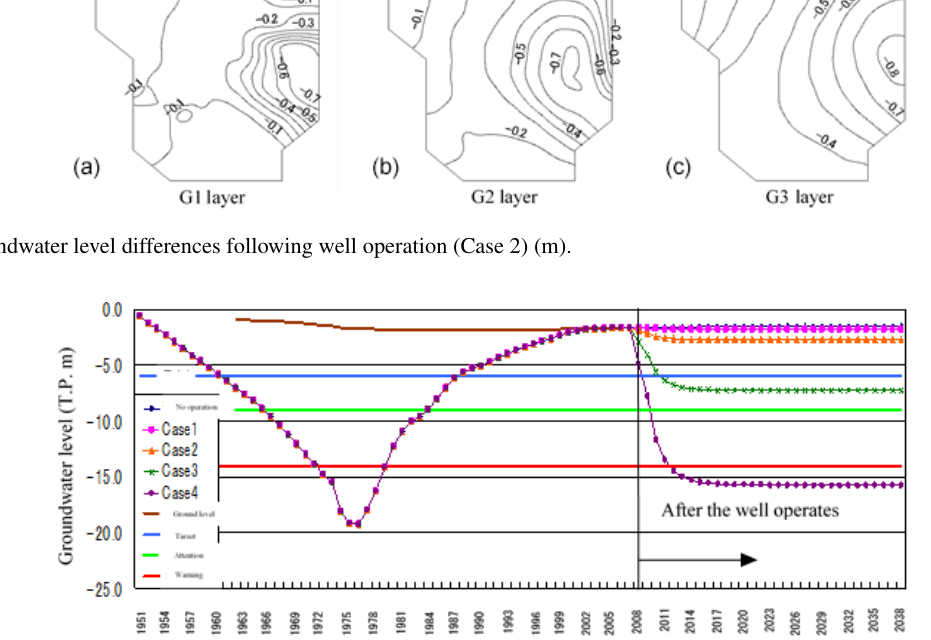
Figure 4. The yearly change of the groundwater level of Jushiyama observation well (G2 layer). “T.P.” refers to Tokyo